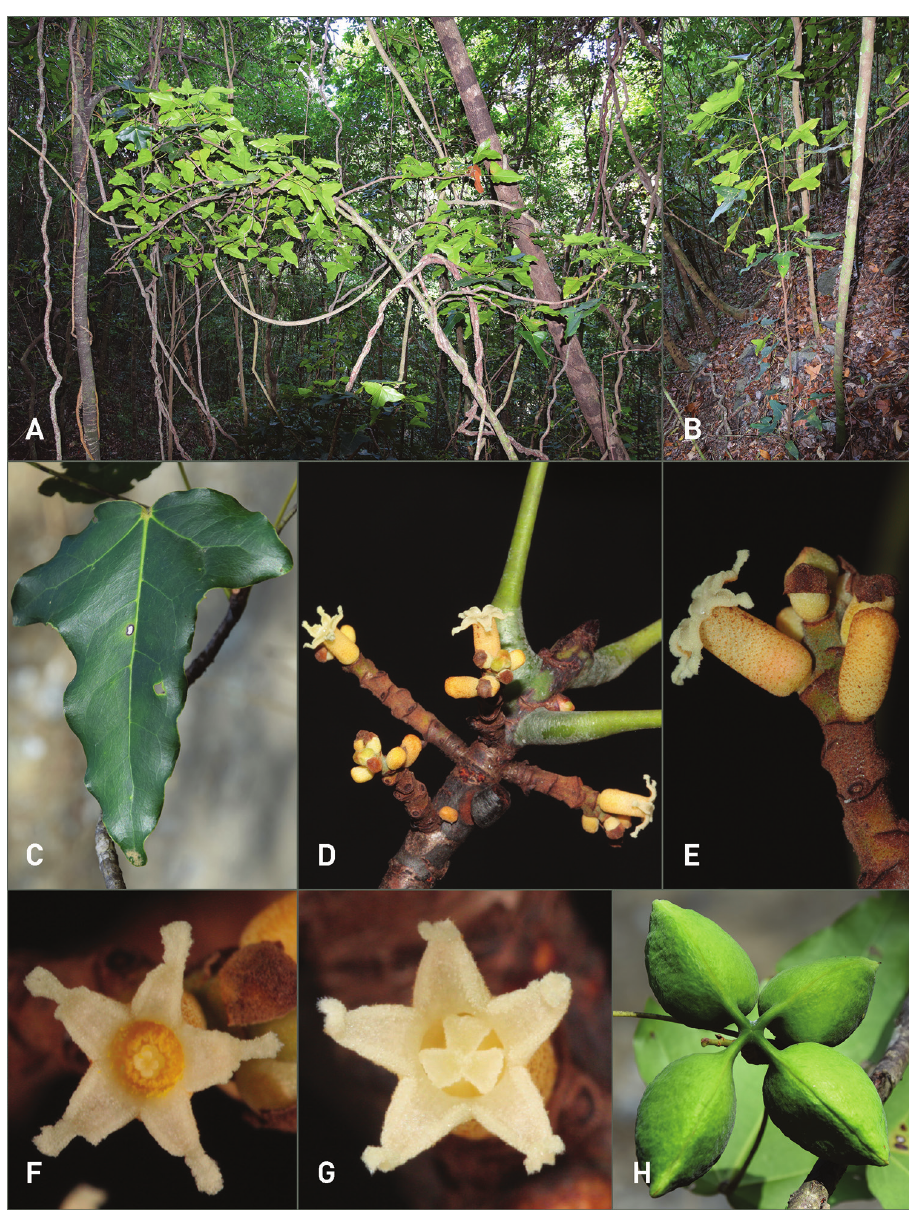
Figure 3. Acropogon horarius Gâteblé & Munzinger sp. nov. A overview of a single mature shrub in habitat B juvenile plant C leaf D flowering branch E inflorescence F male flower G female flower H follicles. Pho- tographs by G. Gâteblé ( A Gâteblé et al. 803 B Gâteblé et al. 804 C–H Gâteblé et al. 806